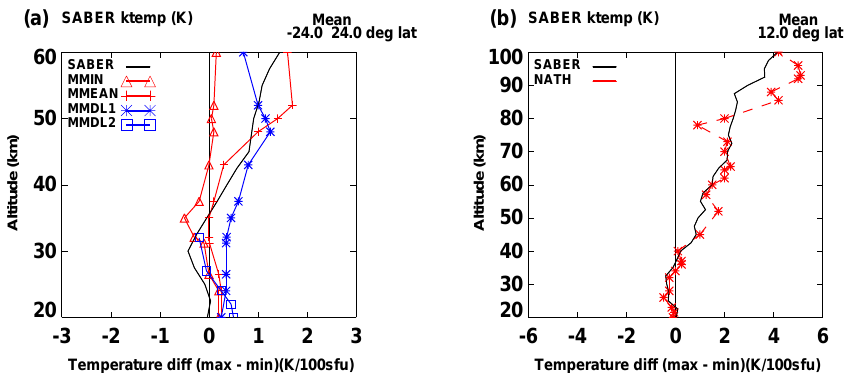
Figure 4. Left panel: black line denotes SABER responses averaged from 24 ◦ S to 24 ◦ N latitude. Red plusses denote the mean of three reanalysis datasets (MMEAN), composited from 25 ◦ S to 25 ◦ N, from Mitchell et al. (2015). Red triangles corresponds to the plusses but for one set of the reanalysis data. Blue asterisks and squares denote responses of two selected models from Mitchell et al. (2015). Right panel: black line represents our SABER responses at 12 ◦ , from 20 to 100km. Red asterisks denote results of Nath and Sridharan (2014), for 10–15 ◦ N latitude, also based on SABER